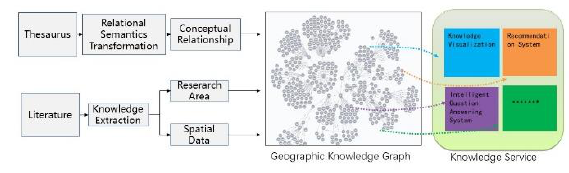
Figure 2 . Overall technology road map.